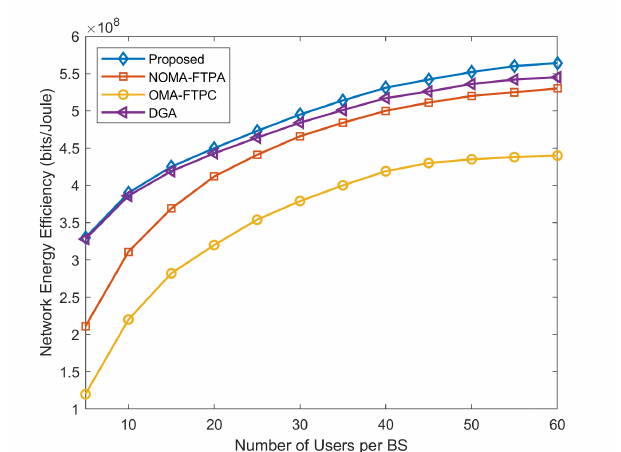
Figure 5. Network EE for different numbers of users per BS.